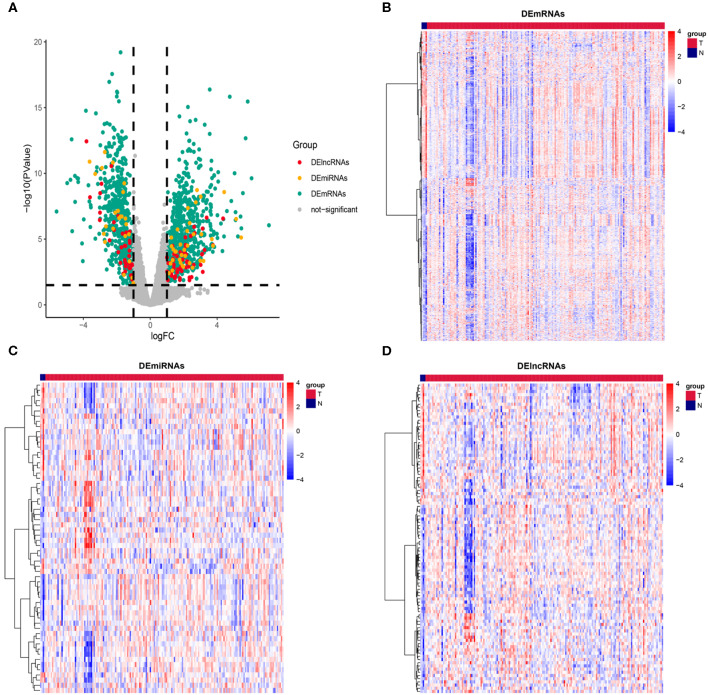
Description of DEmRNAs, DEmiRNAs, and DElncRNAs. (A) Volcano plot showing DEmRNAs (green), DEmiRNAs (yellow), and DElncRNAs (red), The X axis represents logFC, the Y axis represents log10 (P value). Genes with |logFC| ≥ 1 and P ≤ 0.05 were defined as DEGs. Heatmap showing the normalized expression of (B) DEmRNAs, (C) DEmiRNAs and (D) DElncRNAs. T indicates cancer tissue, N indicates paracancerous tissue.